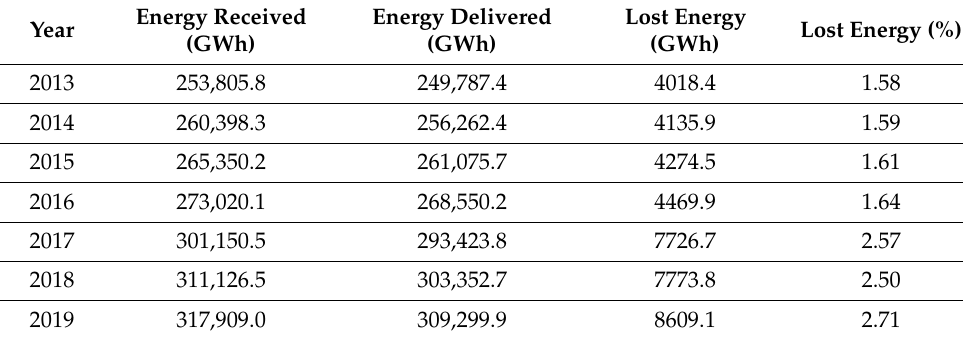
Table 3. Transmission electricity losses,